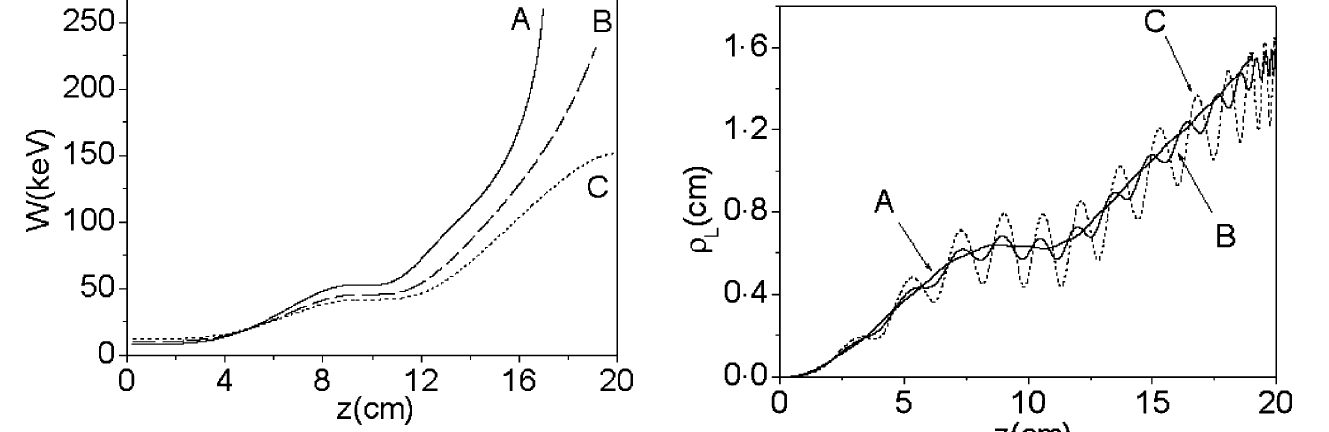
(cid:1) 10 keV , FIG. 8. Larmor radius versus the electron longitudinal posi- i (cid:1) 0 : 0 cm , (B) r tions: (A) r 0